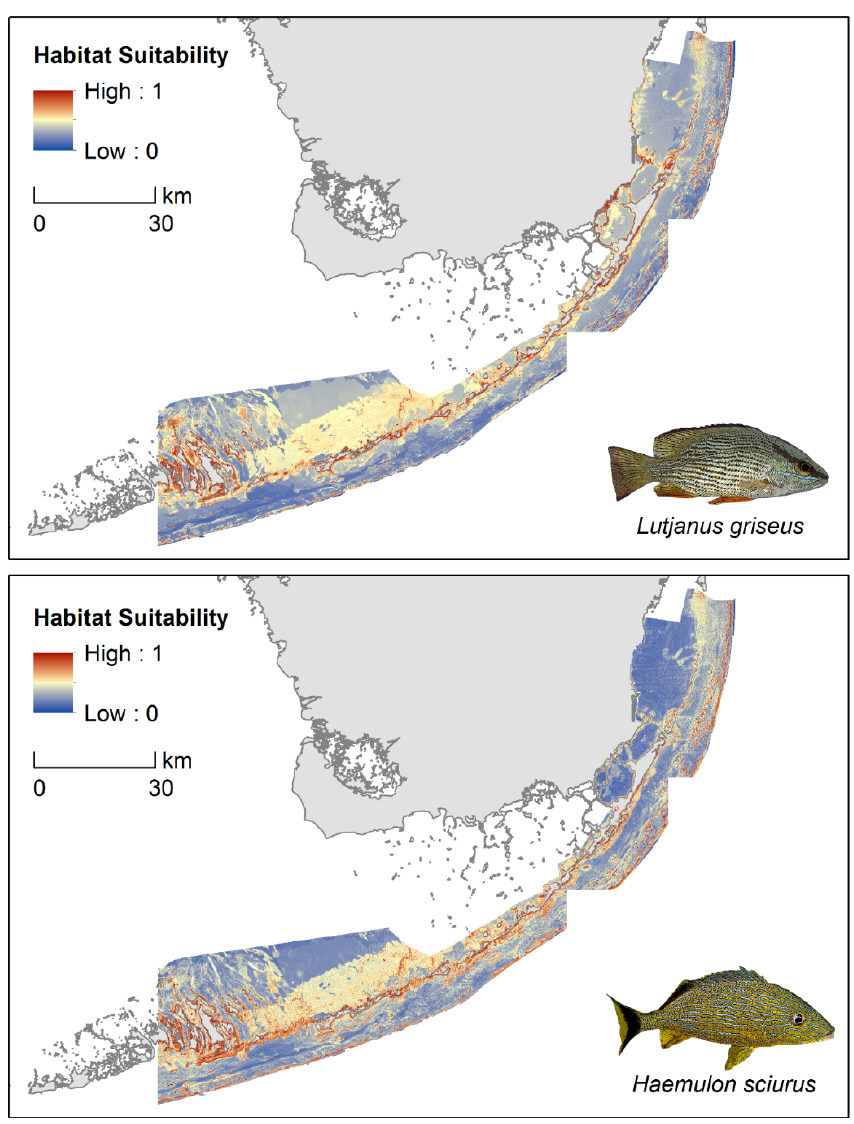
Figure 3. MaxEnt predictions of relative habitat suitability for sub-adult gray snapper ( Lutjanus griseus ) and bluestriped grunt ( Haemulon sciurus ) across the Florida Keys, USA.